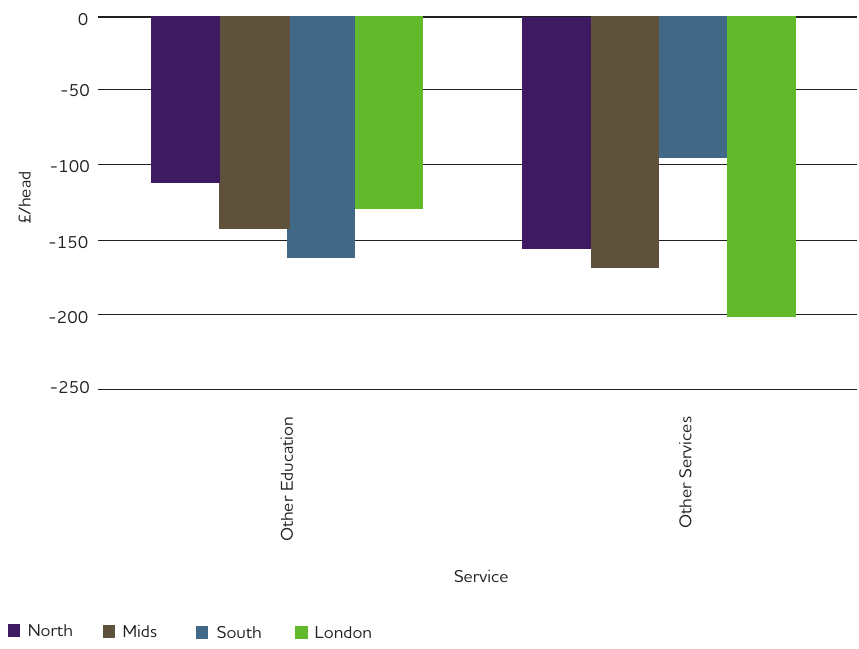
14 The cost of the cuts: the impact on local government and poorer communities